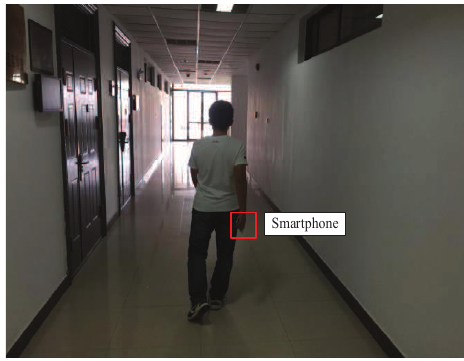
Figure 4. Indoor